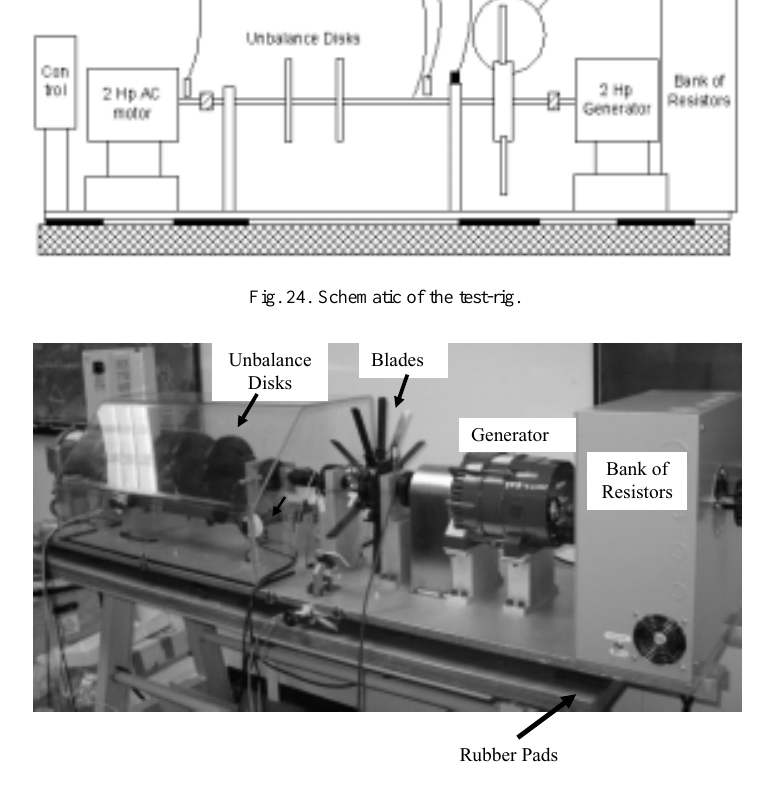
Fig. 25. Photograph of the